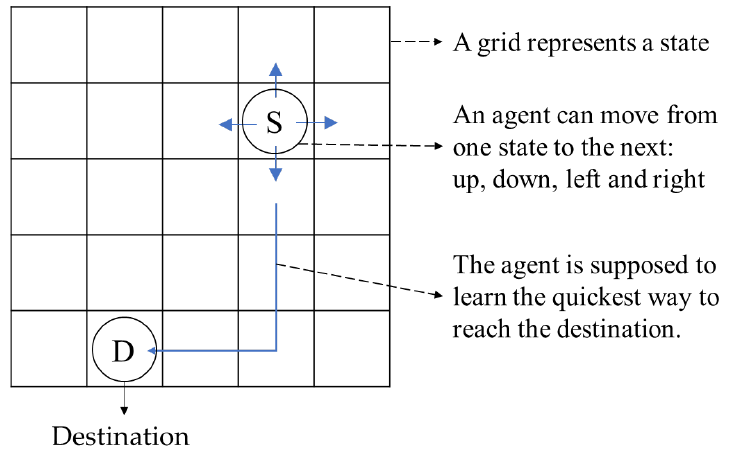
Figure 5. The gridworld with a 5 × 5 grid map.